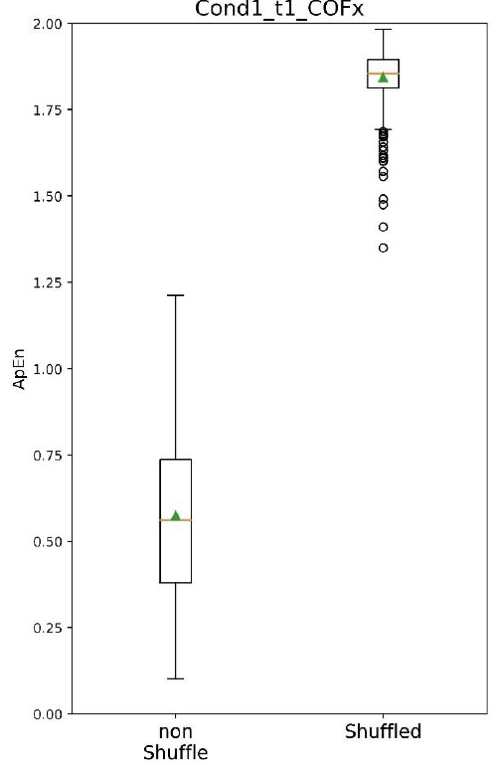
Figure 5. Shuffled/non-shuffled COP — Testing its randomness.